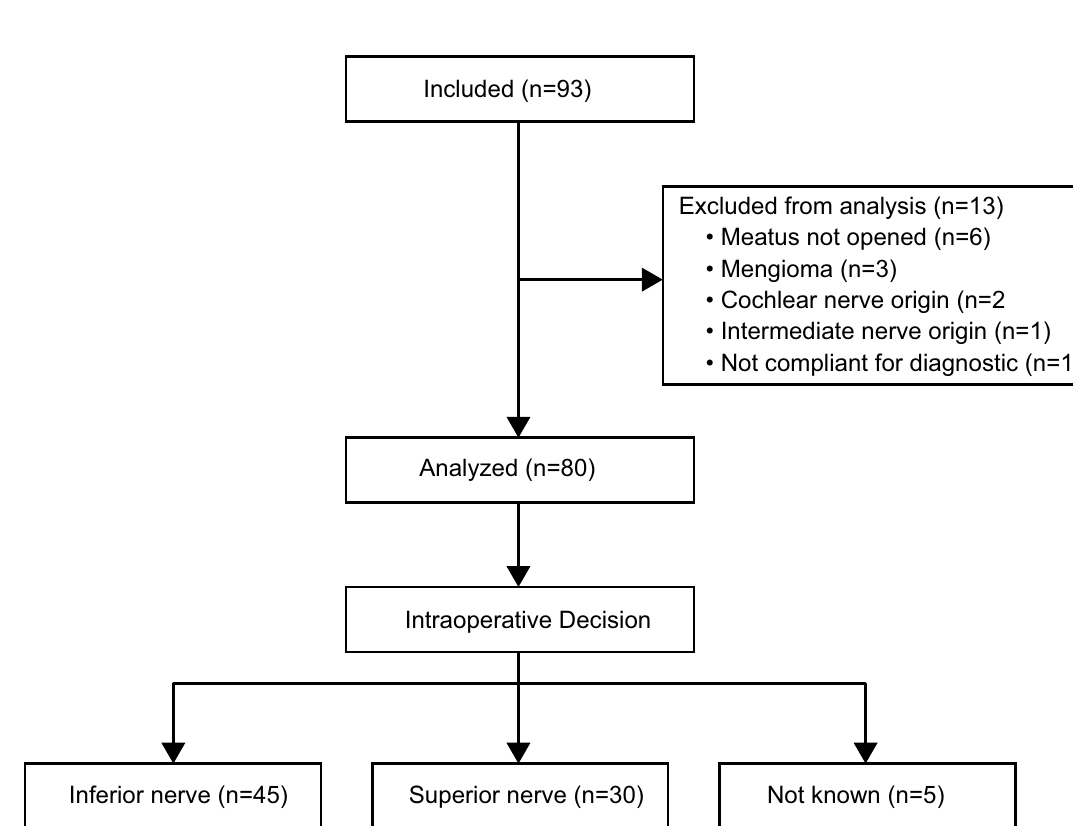
Figure 1. Flow chart of included excluded and analysed patients, as well as distribution of intraoperative decisions regarding nerve of